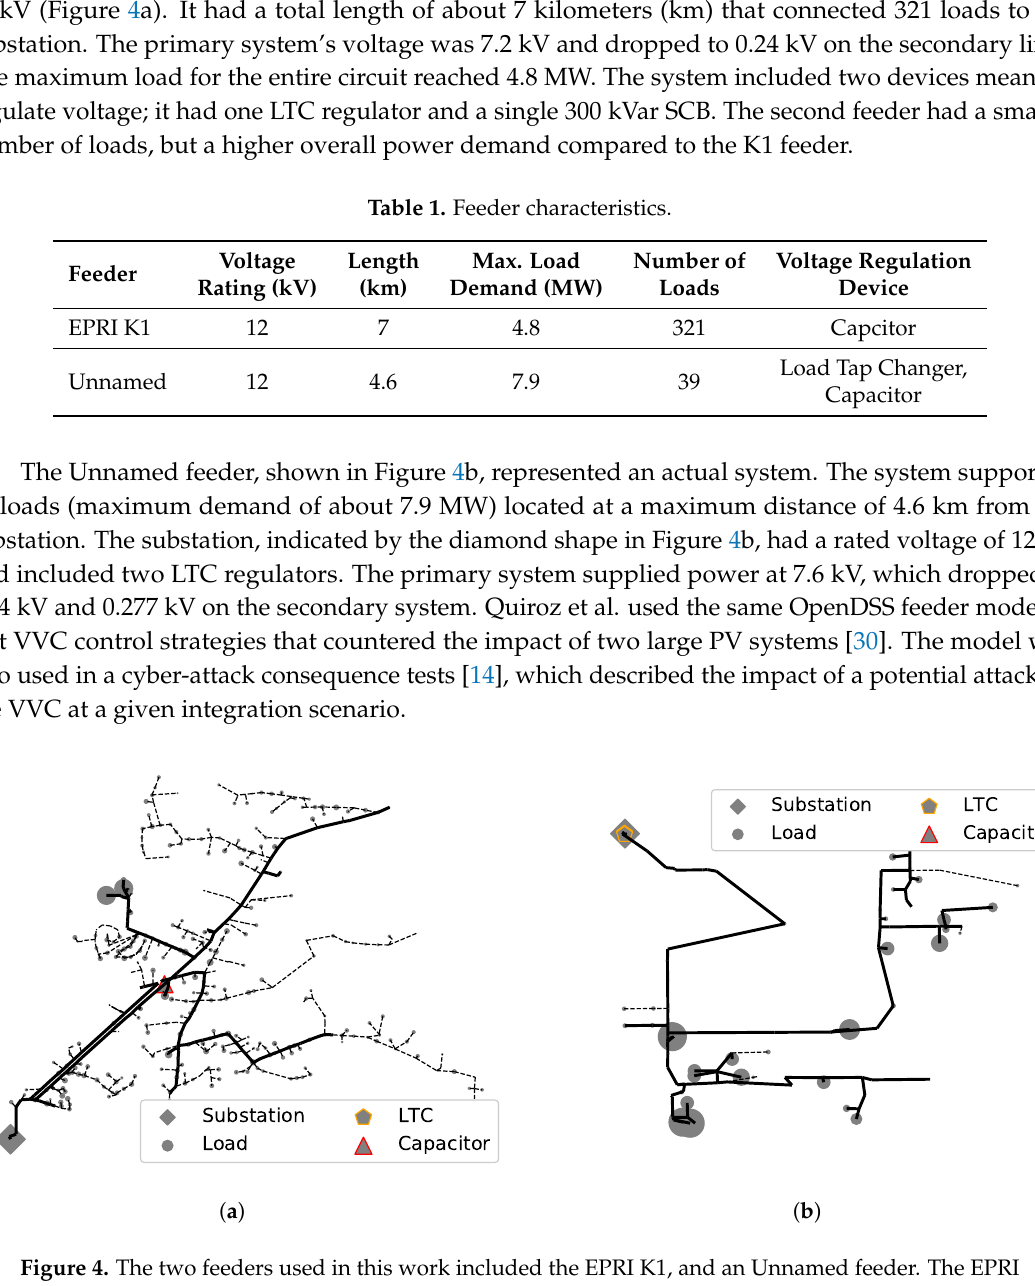
Figure 4. The two feeders used in this work included the EPRI K1, and an Unnamed feeder. The EPRI K1 feeder provided power to 321 loads and included one LTC and one SCB. The Unnamed feeder connected 39 loads to the substation and had two LTCs. ( a ) EPRI K1 Feeder; ( b ) Unnamed